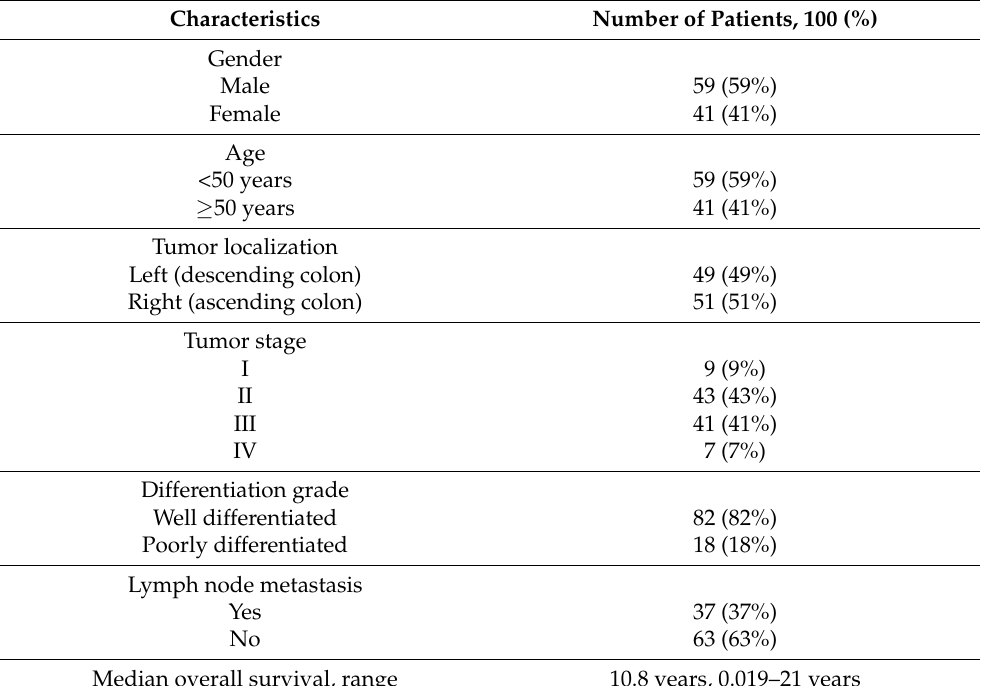
Table 2. Clinical and pathological characteristics of patients.